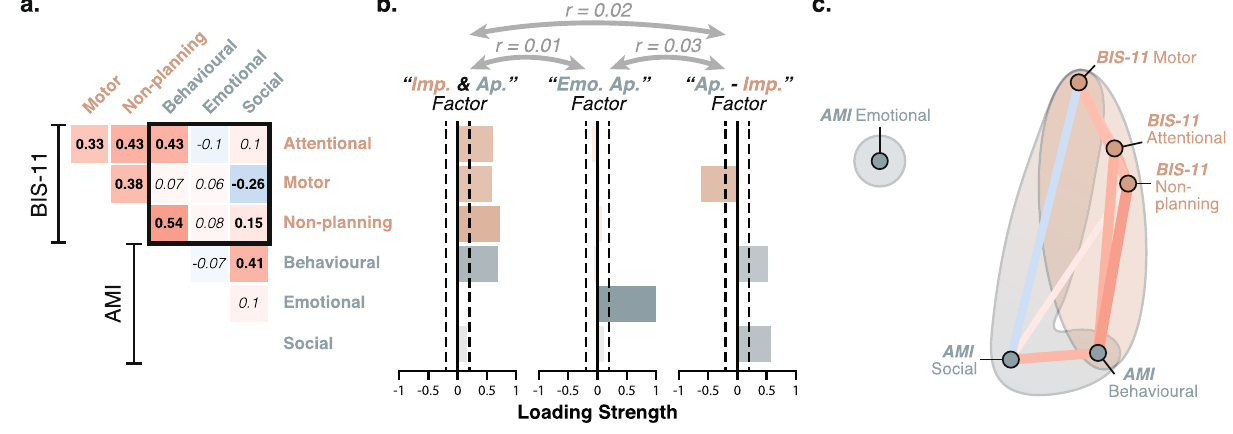
Figure 4. An apathy-impulsivity axis can be uncovered with the AMI and BIS-11. ( a ) The correlation matrix of the sub-scale scores of the AMI and BIS-11 questionnaires showed positive and negative associations (Dataset 5, n = 394 ). Significant correlations are shown in bold (Bonferroni-corrected significance threshold: p < 0.003 ). The black square highlights cross-questionnaire associations. ( b ) Factor decomposition (EFA) of this matrix yielded 3 un-correlated factors (Apathy-Impulsivity overlap, Emotional apathy, Apathy-Impulsivity axis). ( c ) The network plot is shown for visualisation purposes. More highly correlated (positively or negatively) appear closer together and are joined by stronger paths (non-significant paths removed). Paths are also coloured by their sign (red for positive and blue negative). Ellipses are drawn around the sub-scores included in a factor. See also Fig. S3 for replication in an independent